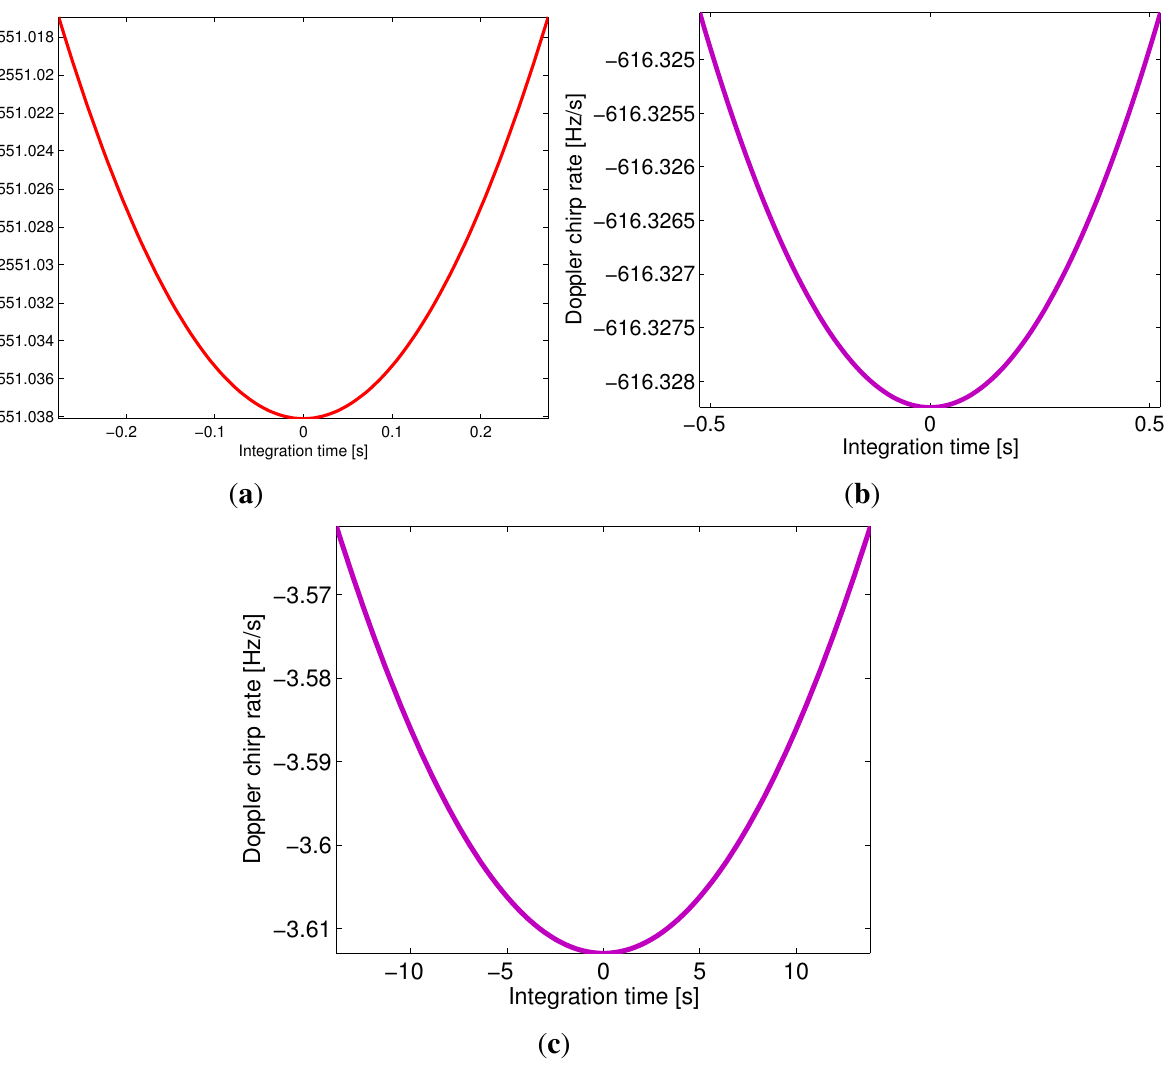
Figure 2. Azimuth-variant Doppler characteristics. ( a ) Configurations A; ( b ) Configuration B; ( c ) Configuration